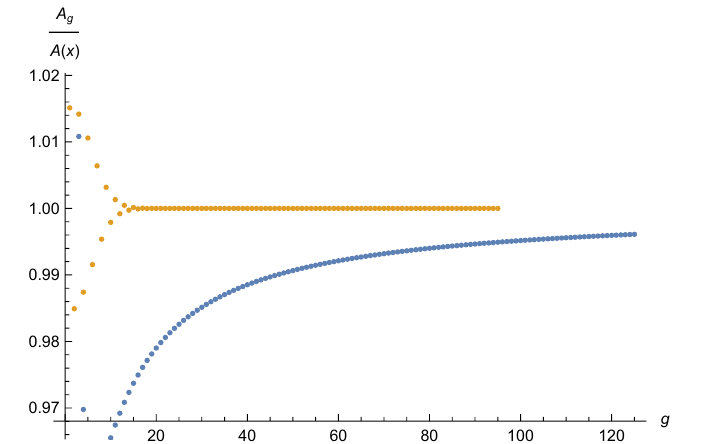
Figure 3. Plot of A g /A ( x ) for λ = 100 . The blue dots represent A g /A ( x ) defined in (5.11) while the orange dots represent its 30 -th Richardson transform A (30) g /A ( x )